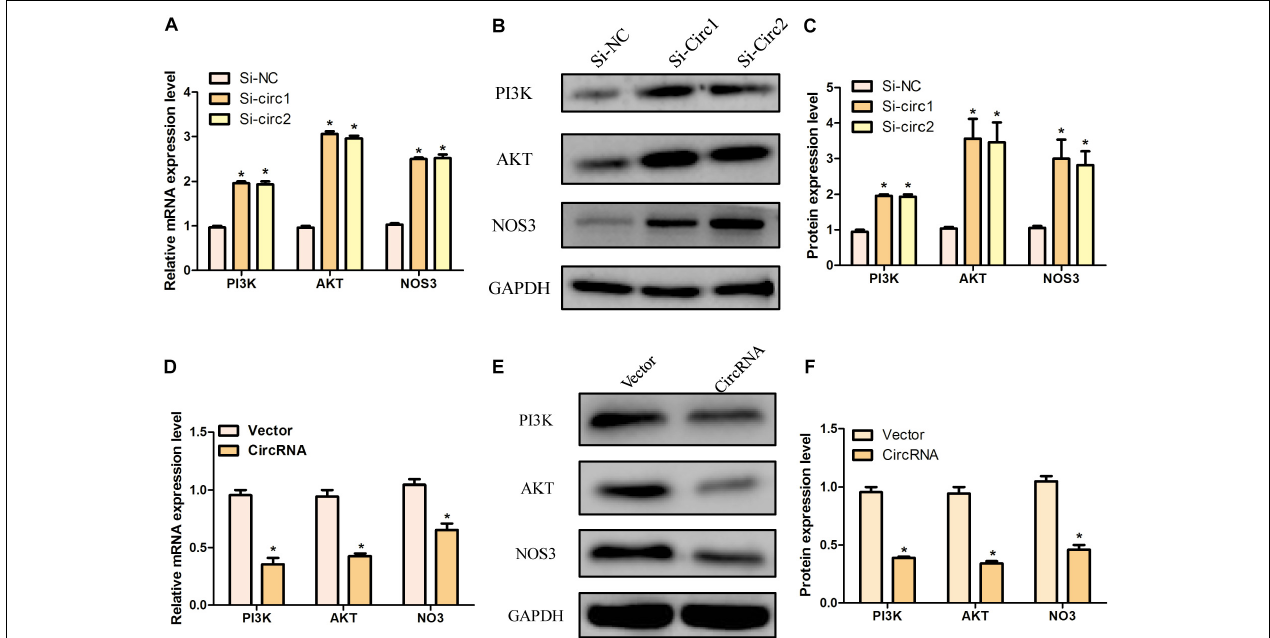
FIGURE 4 | The knockdown and overexpression of hsa_circ_0004543 was influenced by the PI3K/AKT/eNOS pathway. (A) Relative mRNA expression of PI3K, AKT, and eNOS in oxLDL-induced HUVECs with silencing hsa_circ_0004543. (B,C) The expression of the proteins associated with the PI3K/AKT/eNOS pathway with silencing hsa_circ_0004543. (D) Relative mRNA expression of PI3K, AKT, and eNOS in oxLDL-induced HUVECs with overexpression hsa_circ_0004543. (E,F) The expression of the proteins associated with the PI3K/AKT/eNOS pathway with overexpression hsa_circ_0004543. * p < 0.05.